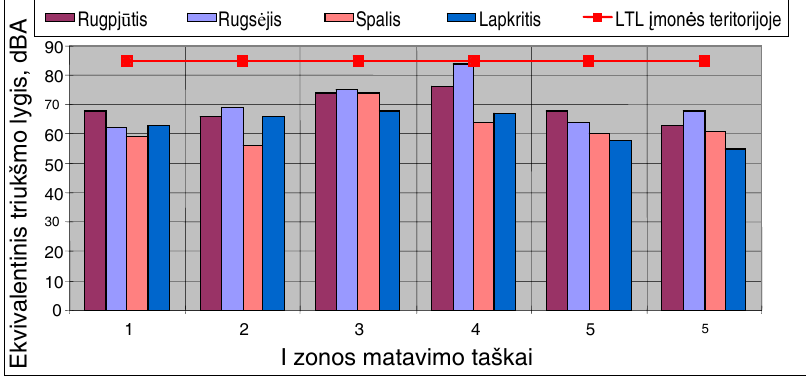
Fig 2. Measuring points of day-time reciprocal noise level on enterprise territory of zone I